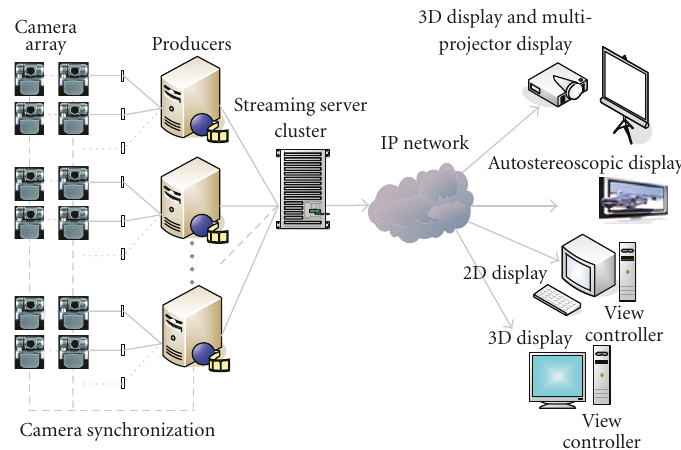
Figure 1: A flexible client-drive 3DTV system.